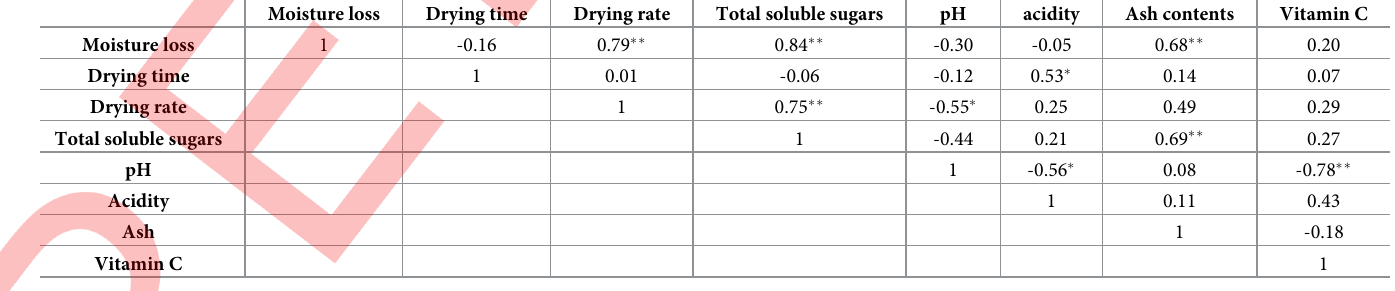
Vitamin C 1 �� and � indicate correlation is significant at the 0.01and 0.05 level,